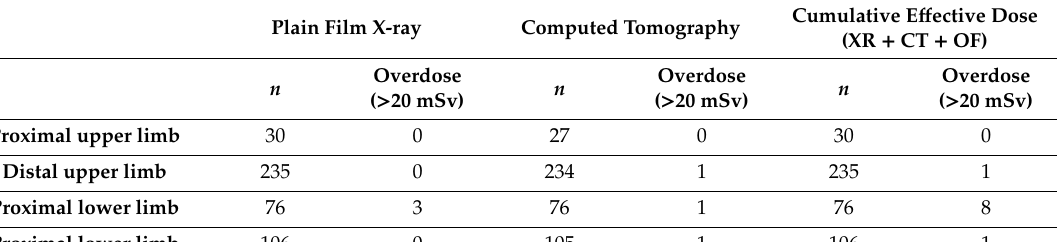
Table 3. Procedures with dose over the annual threshold.